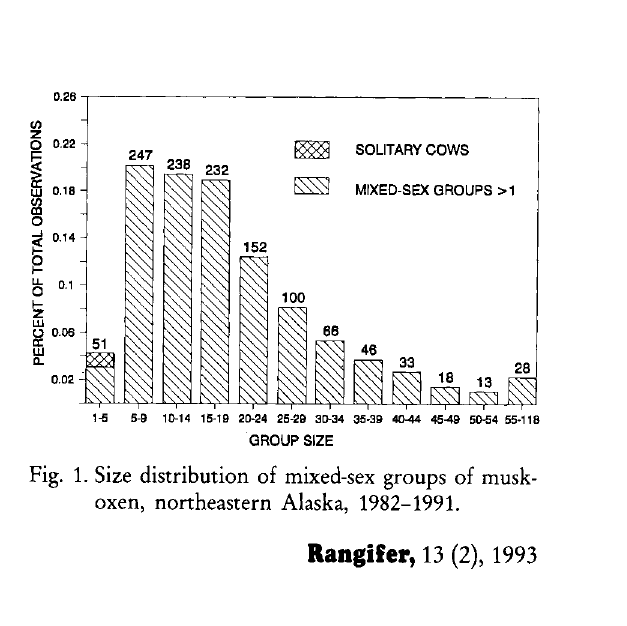
Fig. 1. Size distribution of mixed-sex groups of musk- oxen, northeastern Alaska,